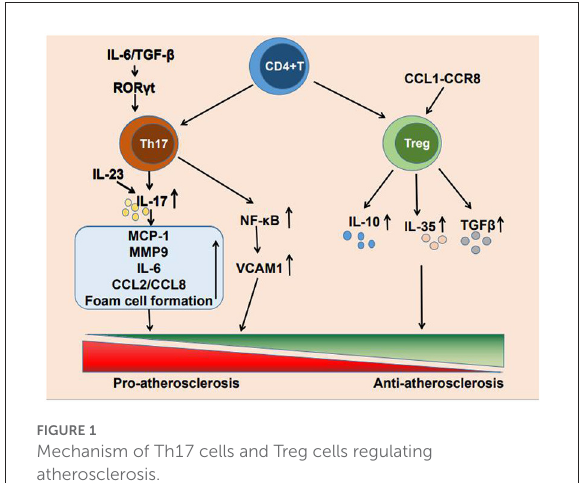
FIGURE1 Mechanism of Th17 cells and Treg cells regulating